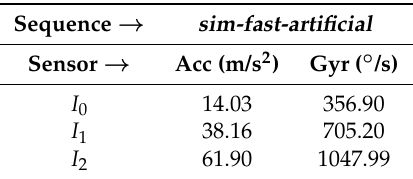
Figure 4. Simulation scenario: angle sequence applied to each rotational DoF of the three segment kinematic chain model (cf. Table 5) used for simulating sim-fast-artificial . Table 6. Peak acceleration (Acc) and angular velocity (Gyr) 2-norms for sim-fast-artificial . For all sensors, the values vary smoothly between 0 and the peak values shown in the